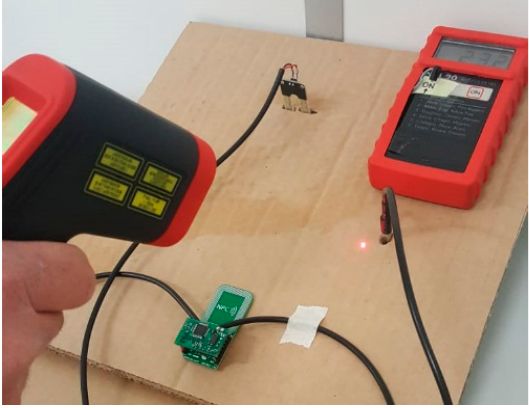
Figure 5. Independent test for sensors’ validation.